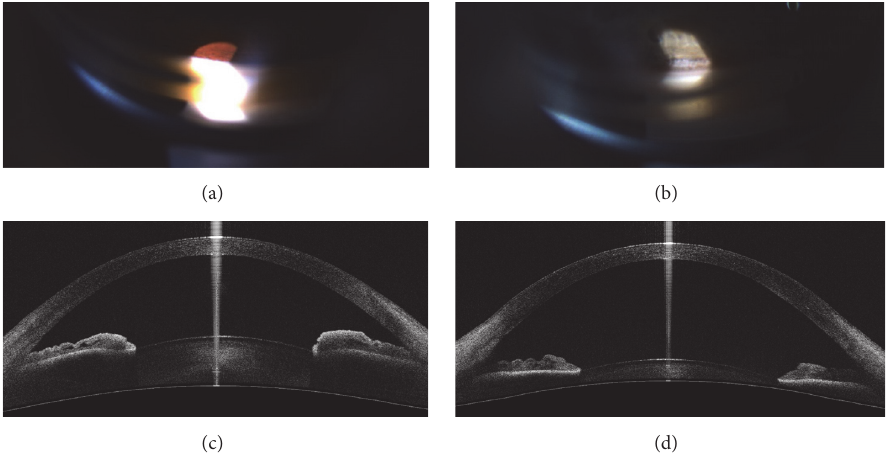
Figure 1: Comparison of a narrow angle and wide-open angle. (a) Gonioscopy image of a narrow angle. (b) Gonioscopy image of a wide-open angle. (c) 2D anterior segment optical coherence tomography (ASOCT) image (vertical) from the CASIA SS-1000 of a narrow angle. (d) 2D ASOCT image (vertical) of a wide-open angle. (a, c) Images from the same eye; (b, d) Images from the same